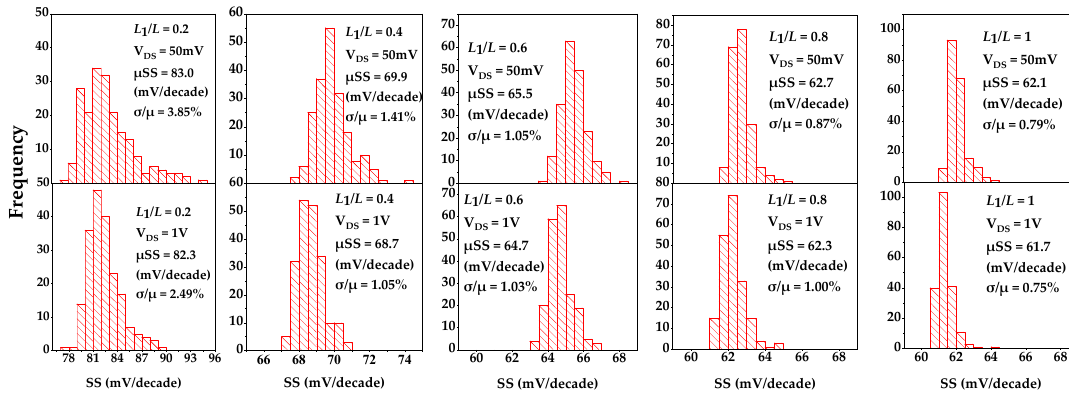
Figure 5. Frequency distribution of sub-threshold swing with different L 1 / L at V DS = 0.05 V and 1 V.